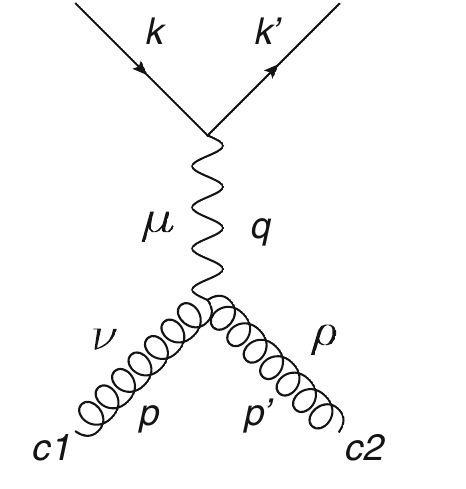
Fig. 1 A schematic graph for electron–gluon scattering